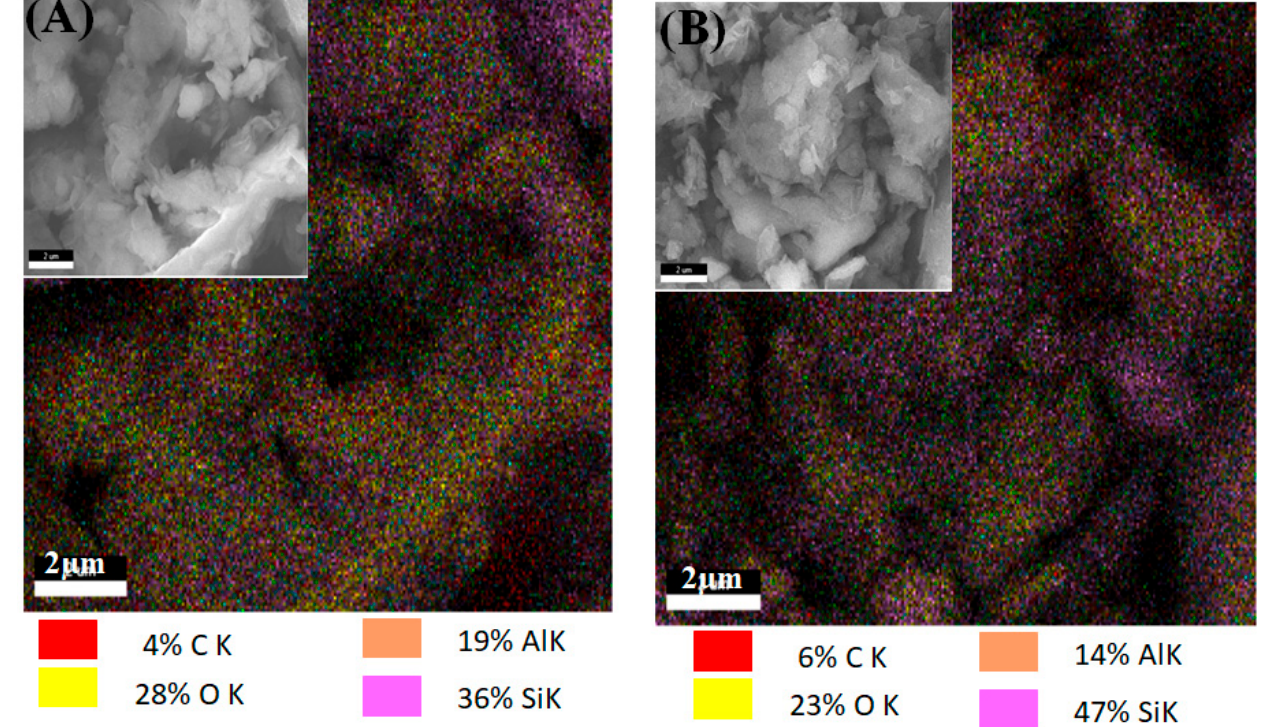
Figure 7. SEM images and EDAX mapping data of ( A ) OFS-L and ( B ) OFS-B modified clay.